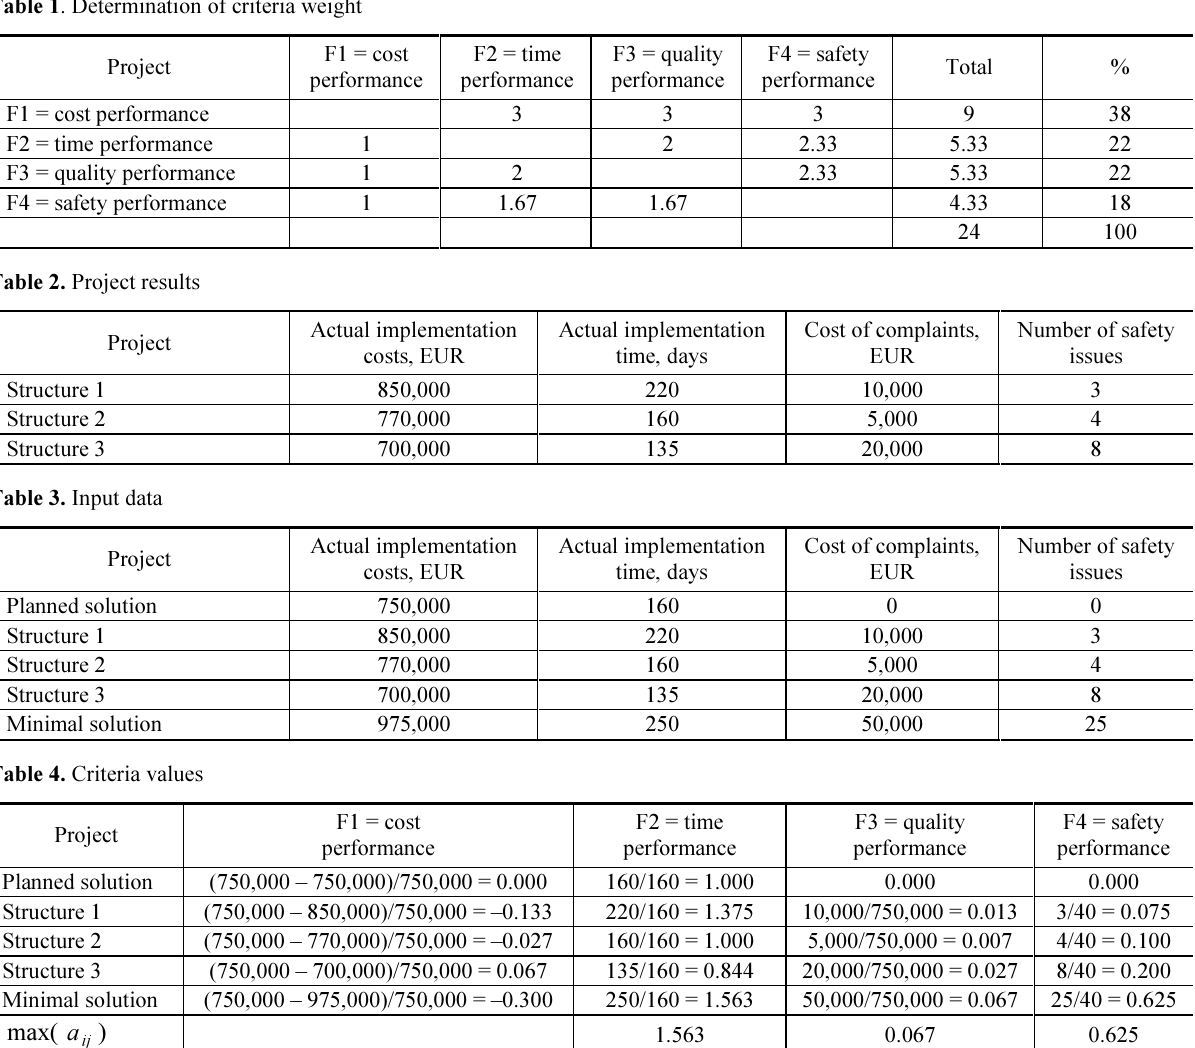
F 3 : quality performance = actual cost of complaint elimination/budgeted cost; F 4 : safety performance = no. of right observations/ total no. of safety issue observations.